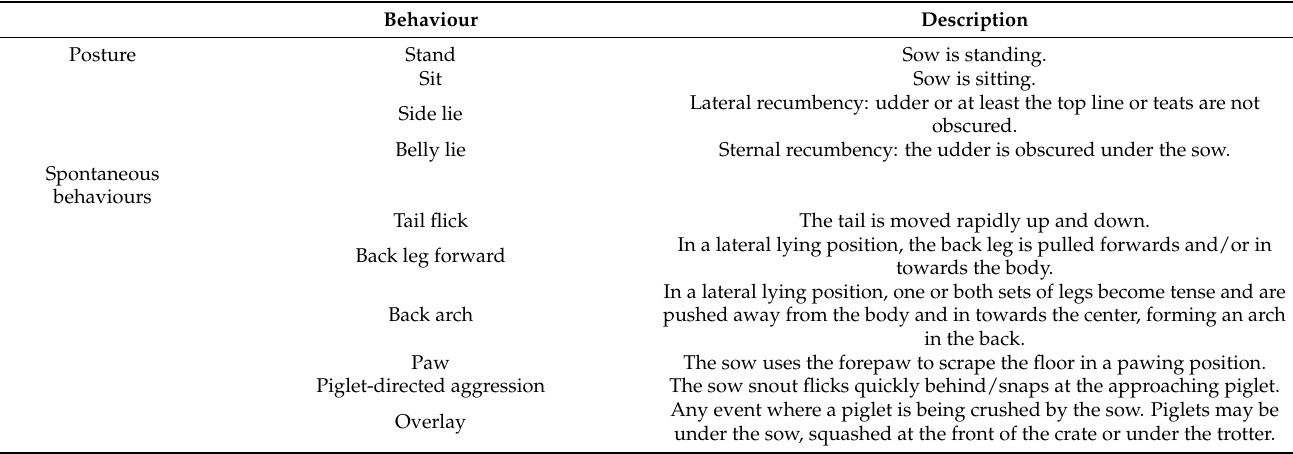
Table 1. Ethogram used for monitoring farrowing behaviour over a 24 h